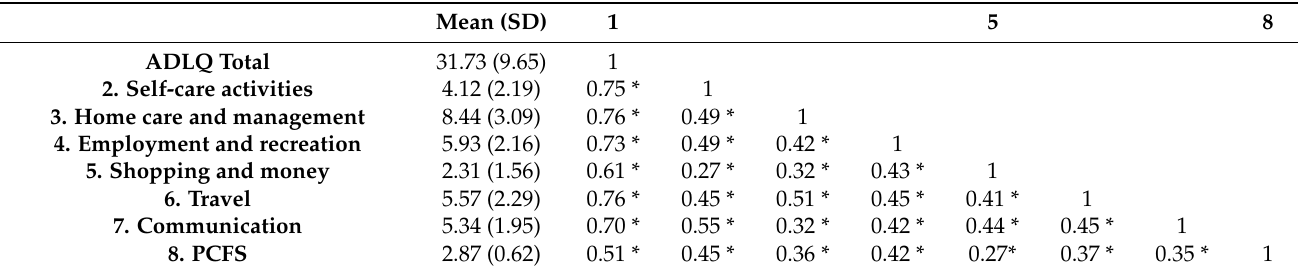
Table 2. Means (SD) and correlations of the